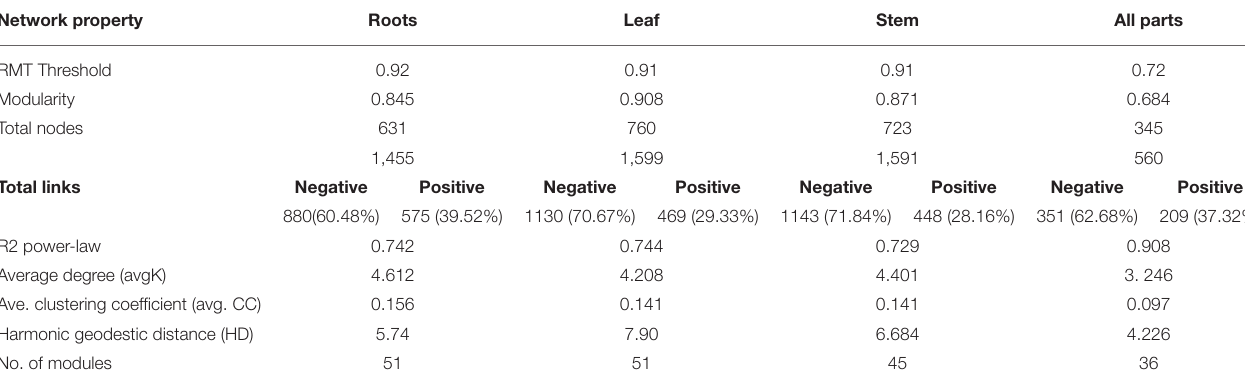
TABLE 3 | Topological properties of molecular ecological networks for nifH -gene harboring bacterial communities. Network property Roots Leaf Stem All parts RMT Threshold 0.92